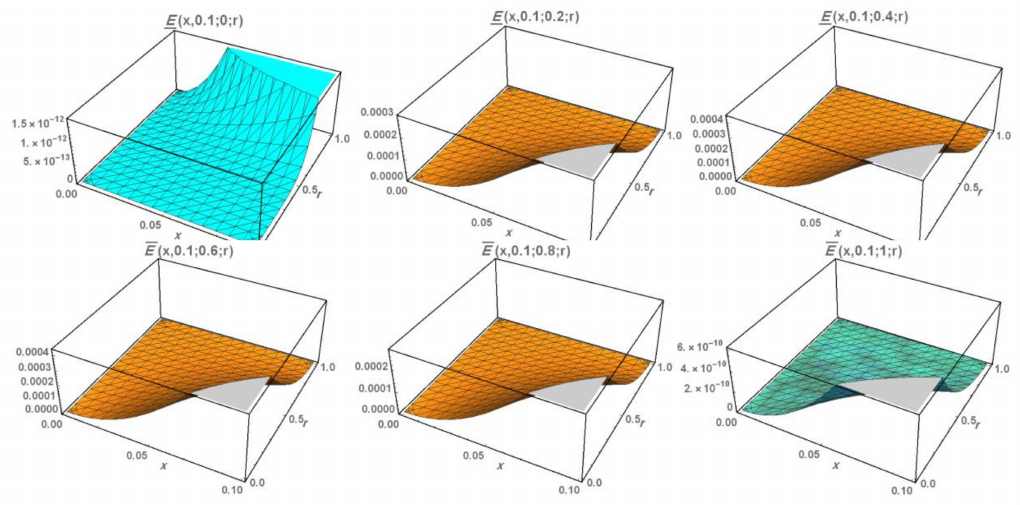
Figure 3. Accuracy of fifth-order HPM solution at t = 0.1, b = 0,0.2,0.4,0.6,0.8,1 for all x ∈ [ 0,0.1 ] and r ∈ [ 0,1 ]